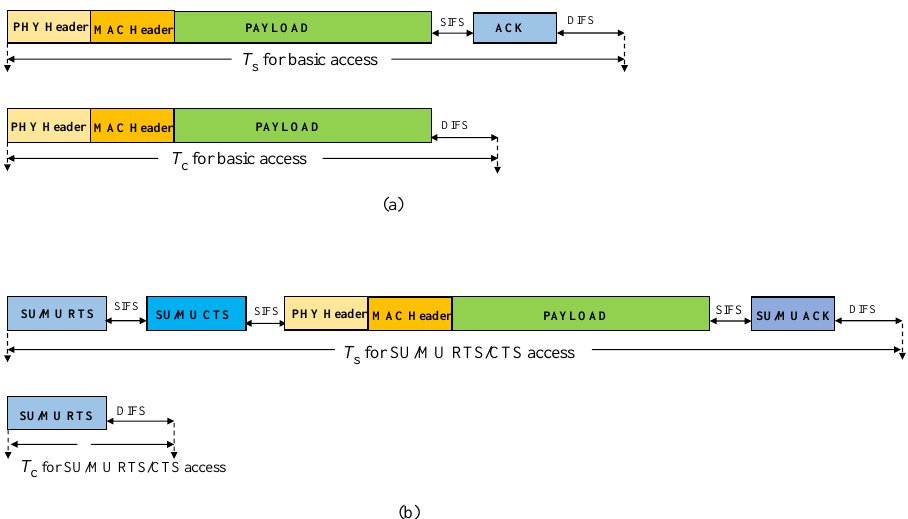
Figure 7. T s and T c calculations for the ( a ) basic and ( b ) SU/MU RTS/CTS access